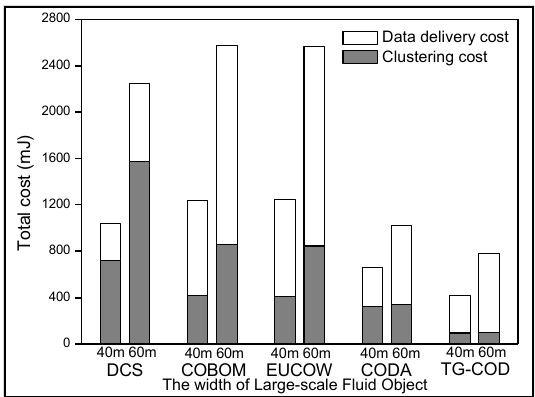
Figure 6. Experimental results for cost with different LFO sizes. Figure 7 represents the impact of the different node density. Each scheme has two results in cases that the number of sensor nodes is 400 and 800. Clustering costs of DCS, COBOM, and EUCOW are not decoupled from the node density as well as from the size of the LFO since more sensor nodes participate in cluster construction along with increase of the node density. DCS constructs more clusters since it decides the size of a cluster on the basis of the number of BNs. Clustering cost of CODA is also not decoupled from the node density unlike the size of the LFO and consumes more energy. TG-COD is not affected by the node density. This result is caused by that CODA construct clusters through communication between sensor nodes whereas TG-COD constructs virtual clusters which refers to an independent coordinate. Data dissemination cost of DCS is not decoupled from the node density since it constructs more clusters and the effect of integration is reduced. COBOM and EUCOW consumes more energy for data dissemination than CODA and TG-COD due to the restricted clustering but they are decoupled from the node density. Decoupling of COBOM, EUCOW, CODA, and TG-COD in terms of data dissemination cost is caused by that the sizes of their clusters are not changed by the node density.